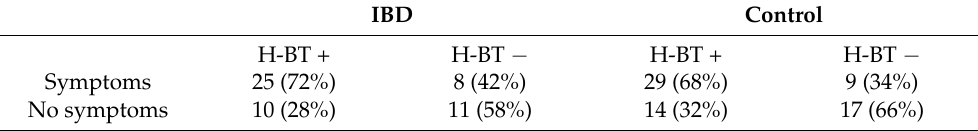
Table 2. Symptoms recorded during the H-BT test in IBD patients and control